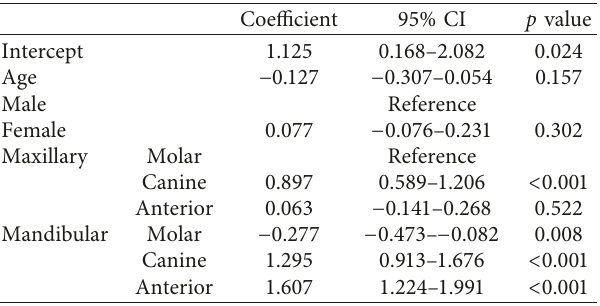
Table 4: Results of multilevel modeling for the prevalence of dental caries at the tooth